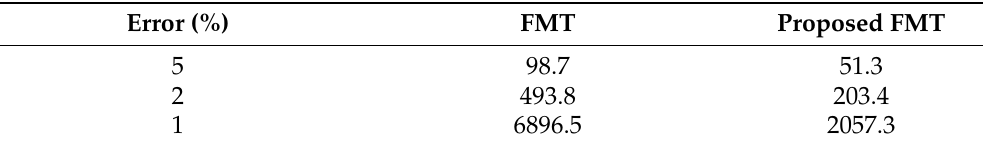
Table 2. Average computing time (ms) for scenarios between two points separated by a distance of 500 cells.